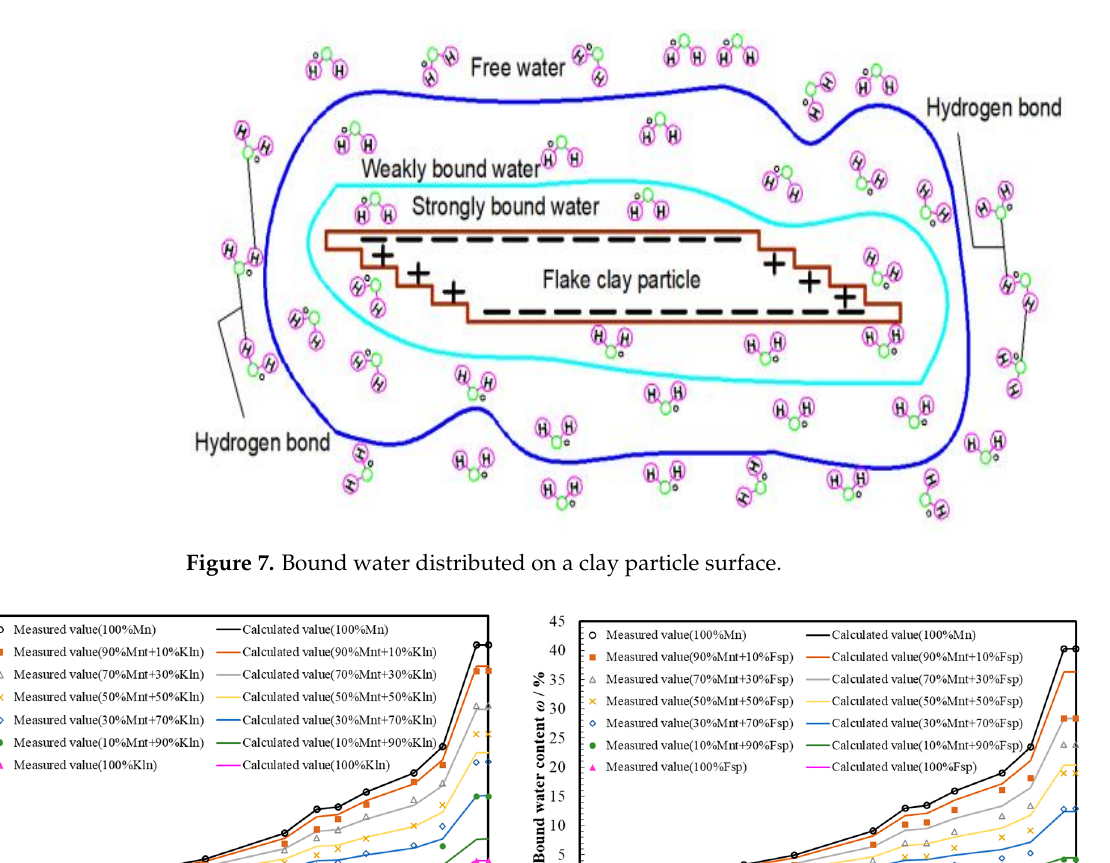
Figure 6. Relationship between bound water and SSA of soils.